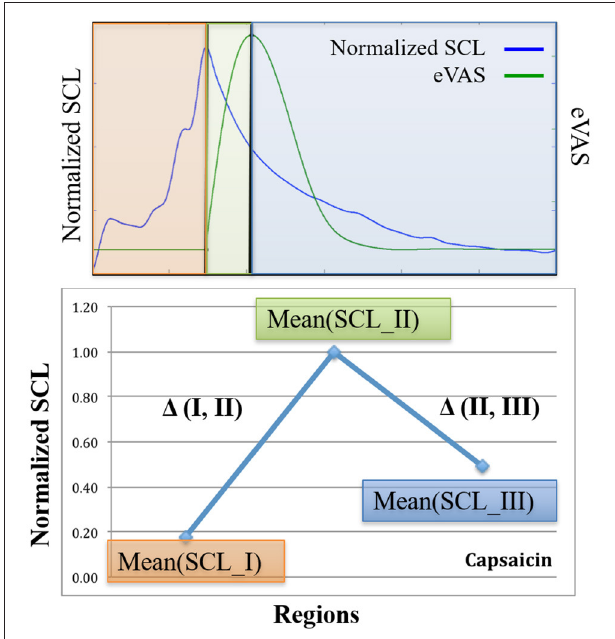
Comparisonismadebetweenthefirstvisit,TV(notreatmentforCold1orCold2),andlater visitsA,B,C.Asdesiredinameasure,alloftheno-treatmentconditionsdonotdifferover FIGURE 6 | Notation for Capsaicin regions and